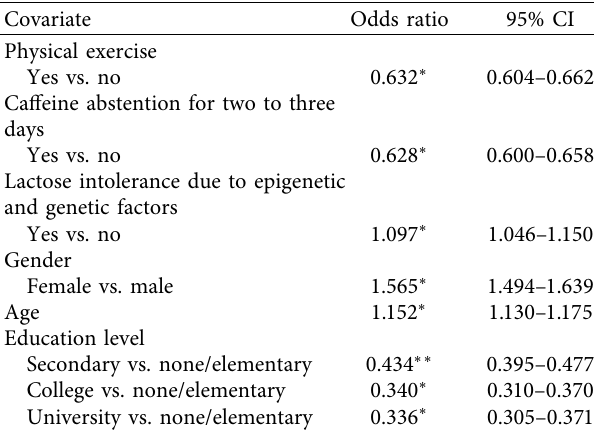
Table 2: Estimated odds ratios, 95% confidence intervals (CIs), and the Wald Z statistic for the effects of selected variables on odds of perceived high risk of osteoporosis in Lebanon based on survey logistic